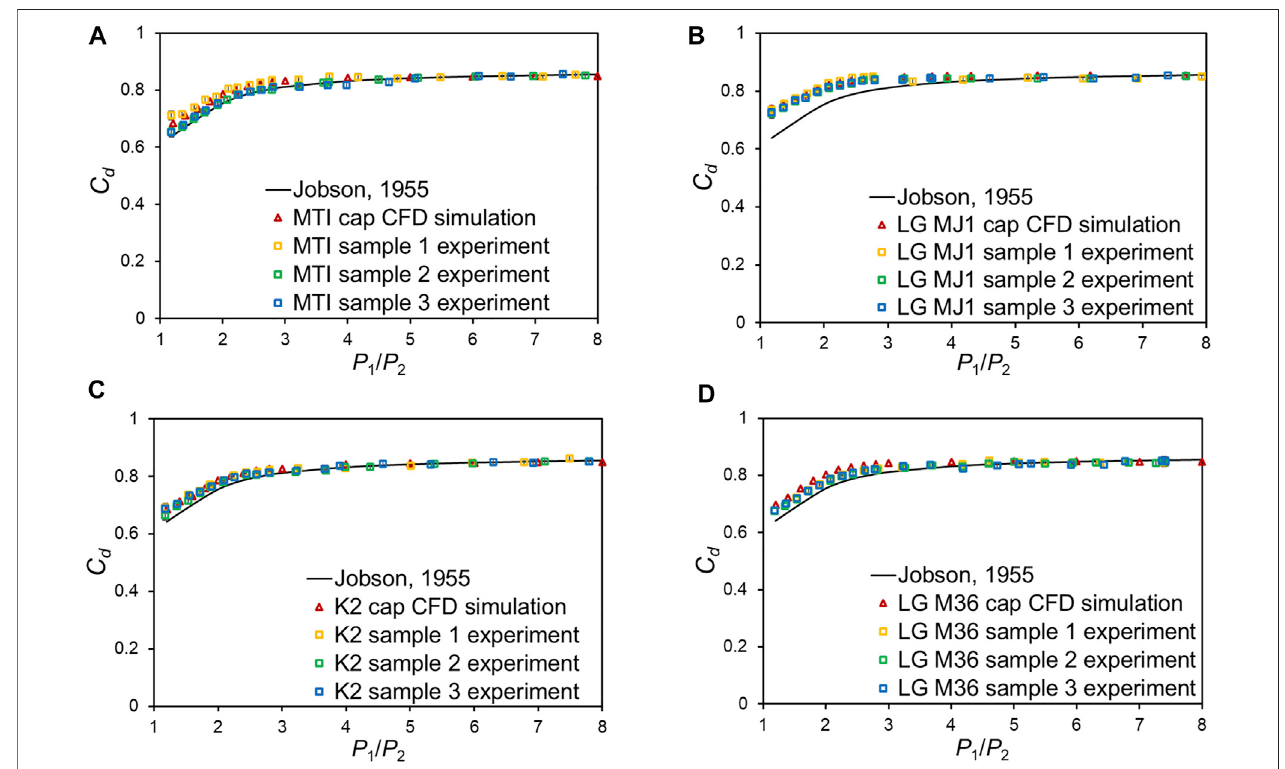
FIGURE 5 | RANS simulated discharge coef fi cients for the MTI cap (A) , LG MJ1 cap (B) , K2 cap (C) , and LG M36 cap (D) .